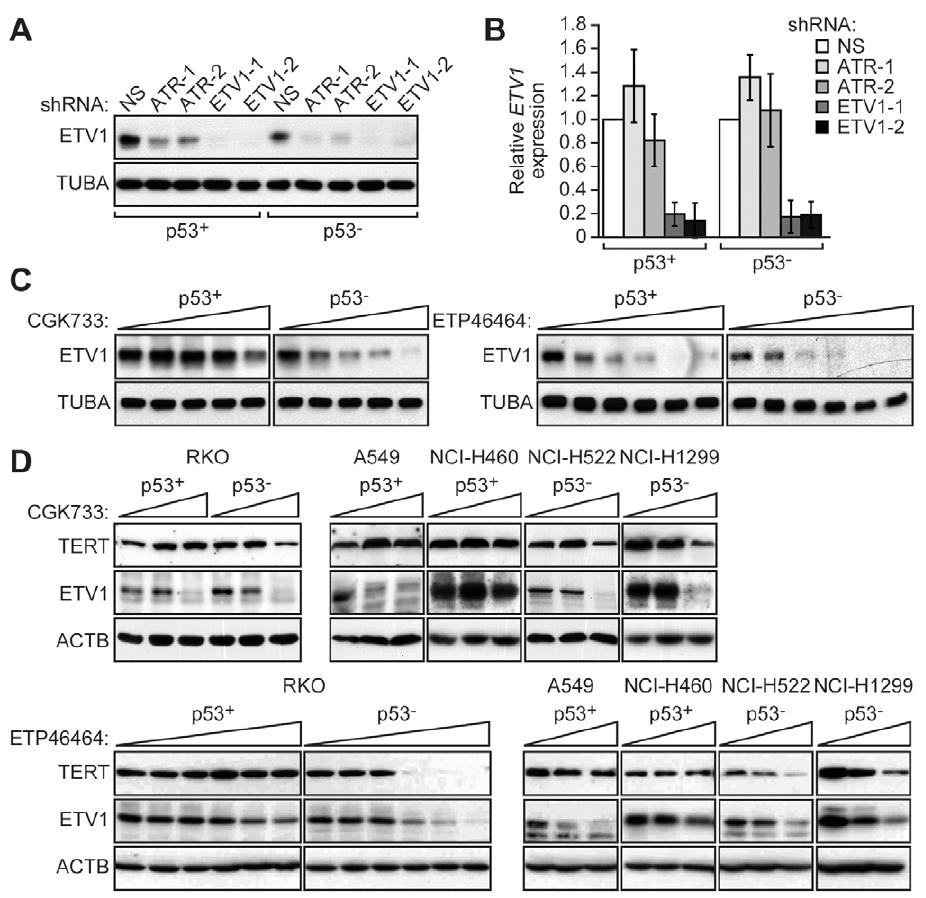
Figure 5. ATR is required for ETV1 stabilization. (A) Immunoblot analysis showing ETV1 levels in p53 + and p53 2 HCT116 cells expressing a NS, ATR or ETV1 shRNA. a -tubulin (TUBA) was monitoring as a loading control. (B) qRT-PCR analysis monitoring ETV1 expression in p53 + and p53 2 HCT116 cells expressing a NS, ATR or ETV1 shRNA. ETV1 expression was normalized to that obtained with a NS shRNA, which was set to 1. Error bars represent SD. (C) Immunoblot analysis showing ETV1 levels in p53 + and p53 2 HCT116 cells treated with CGK733 (left; 0, 2, 3, 4 and 5 m M) or ETP46464 (right; 0, 0.5, 1, 2, 4 and 8 m M). (D) Immunoblot analysis showing TERT and ETV1 levels in p53 + and p53 2 RKO cells, as well as A549, NCI- H460, NCI-H522 and NCI-H1299 cells treated with CGK733 (top; 0, 2 and 4 m M) or ETP46464 (bottom; 0, 0.5, 1, 2, 4 and 8 m